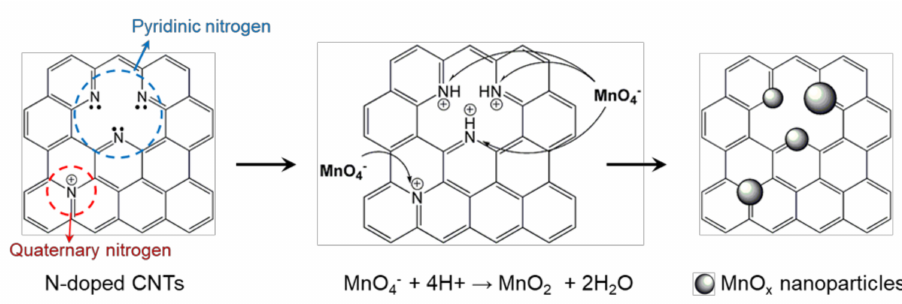
Figure 4. Schematic diagram of possible nucleation mechanism of MnO x nanoparticles at quaternary N (N Q ) and pyridinic N (N P